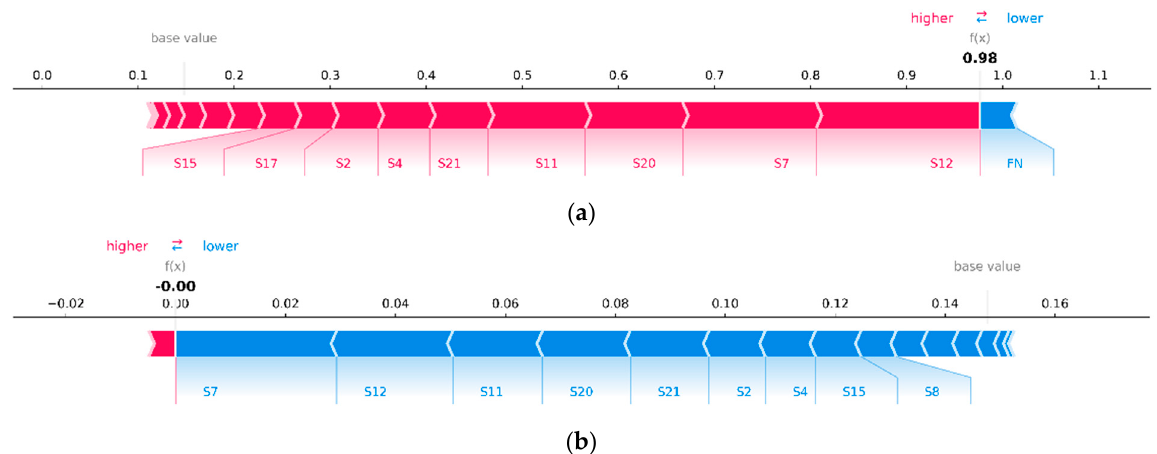
Figure 7. Contribution of features to the probability of failure of engines #81 ( a ) and #99 ( b ), where the base value is the average predicted value on the training set (or the value that would be predicted by the trained model if no features of the test engine were known, i.e., the values of all its features are equal to